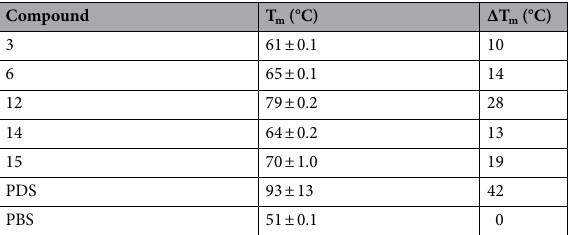
Table 1. FRET analysis of G-quadruplex melting temperatures in the presence of tested compounds at a concentration of 2 μM. PDS (pyridostatin)—positive control, PBS (buffer)—negative control. The ΔT m was calculated by subtracting the average T m of PBS (control) from average T m for each compound. The T m results were averaged from three independent experiments, depicted as mean and standard error.